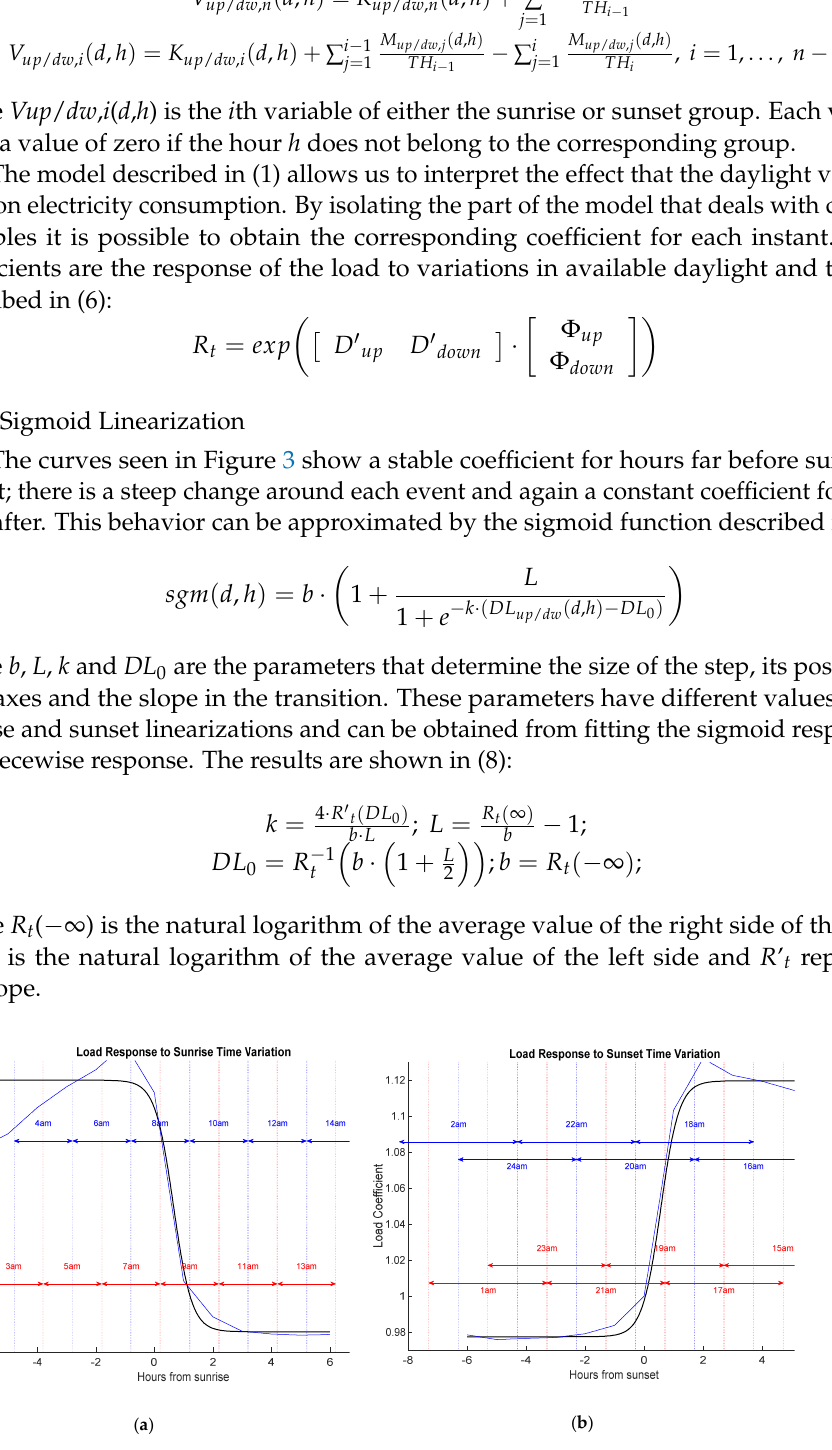
Figure 3. Response to daylight as a coefficient for the expected load. Both piece-wise and sigmoidal linearizations are represented to show a good fit between them. (a) sunrise and (b) sunset.